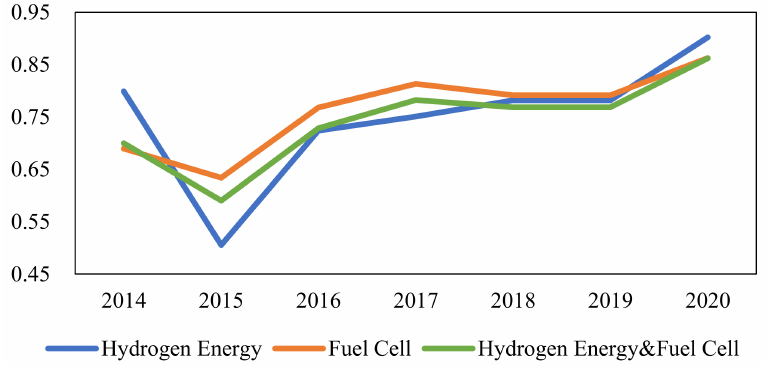
Figure 1. Financing efficiency value by